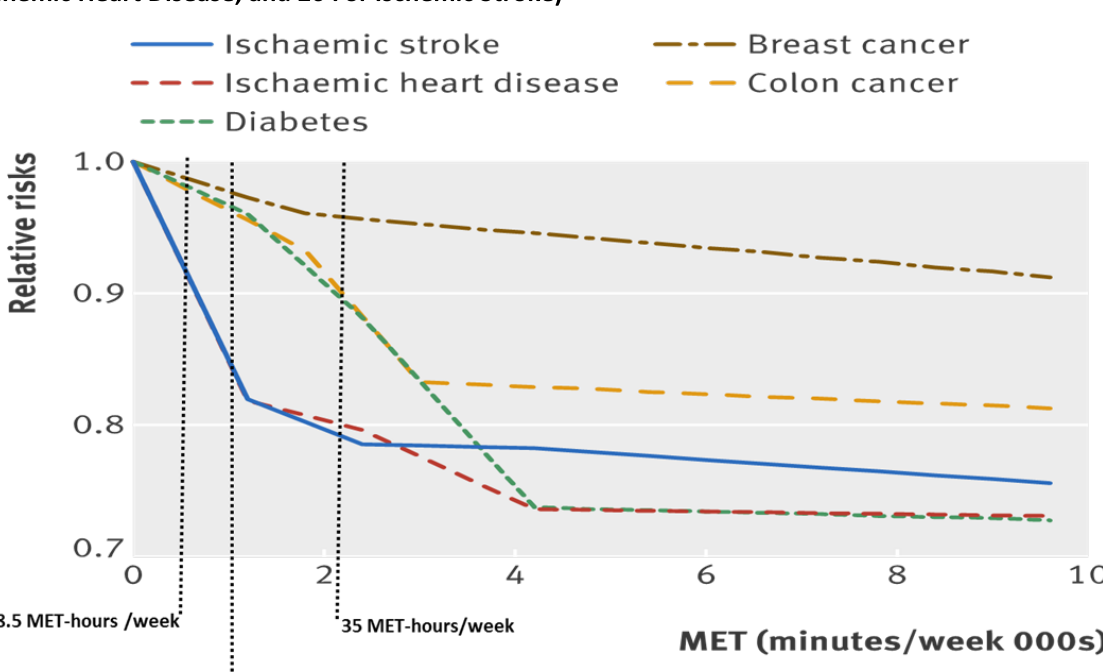
Figure F6-6. Dose-Response Relationships Between Total Physical Activity and Risk of Breast Cancer, Colon Cancer, Diabetes, Ischemic Heart Disease, and Ischemic Stroke Events Using 174 Studies (43 For Ischemic Heart Disease, and 26 For Ischemic